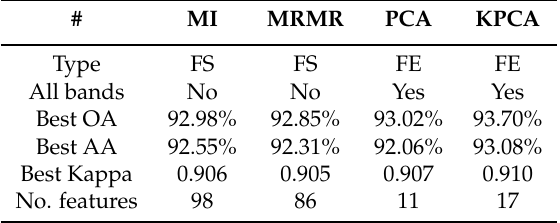
Table 1. Comparisons between feature selection (FS) and feature extraction